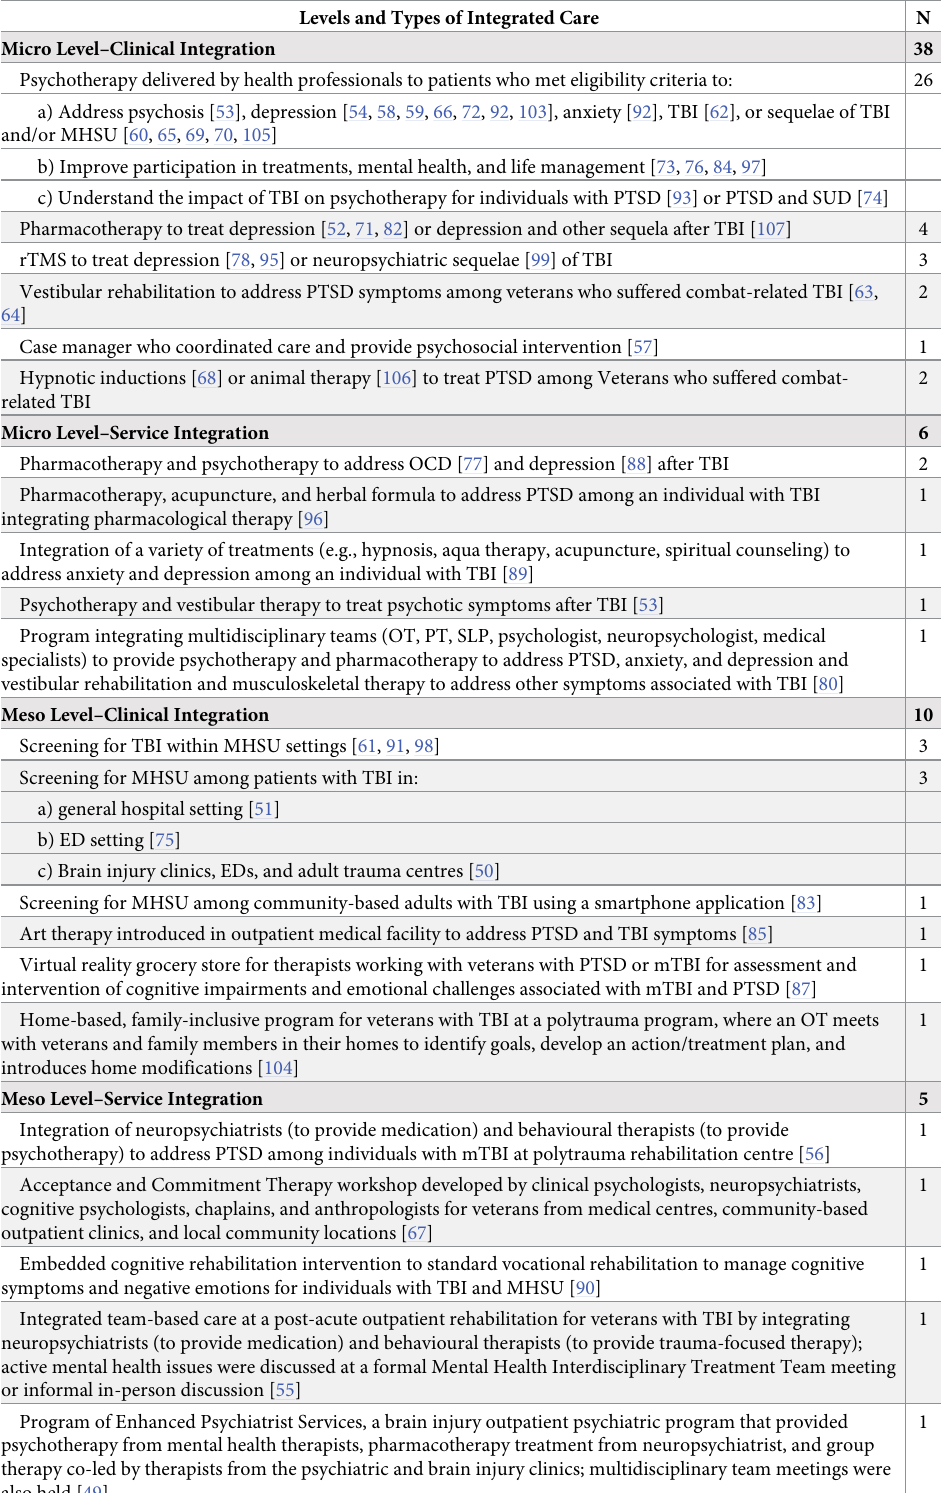
Table 3. Summary of levels and types of integrated